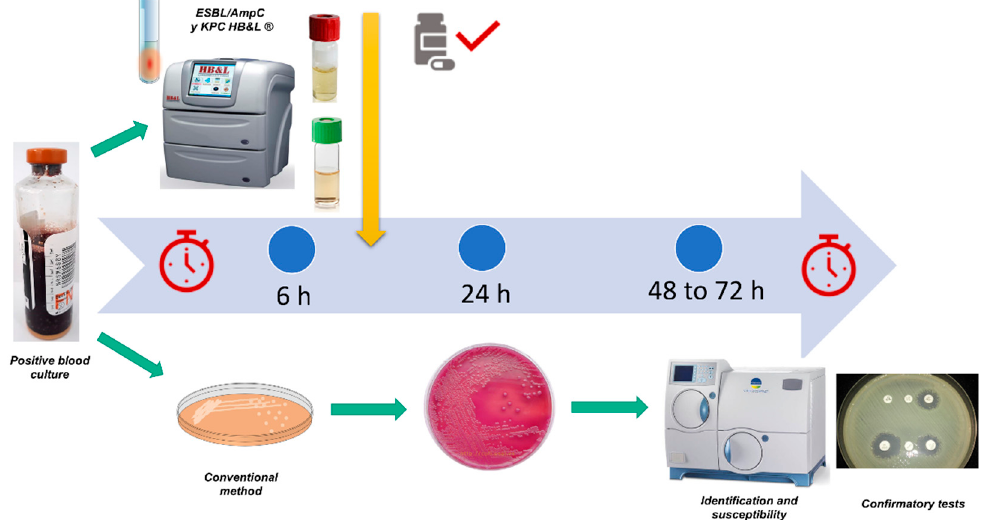
Figure 3. Comparison of response times for each technique (turnaround time). Above the